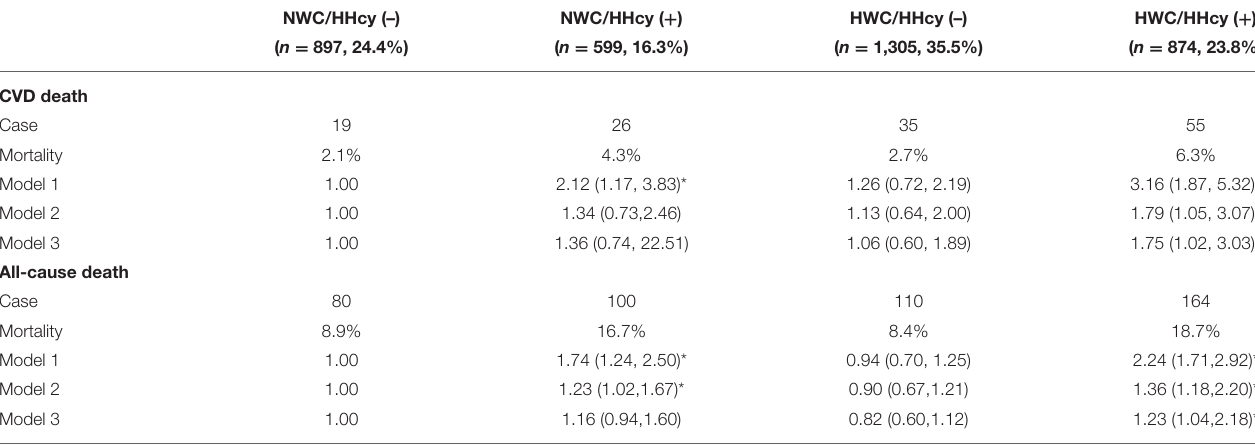
TABLE 4 | HRs for 7-year CVD and all-cause death associated with WC/HHcy